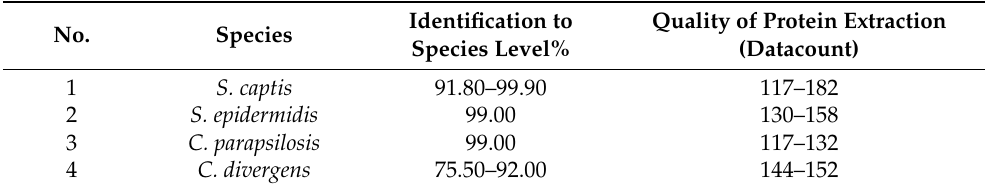
Table 1. Identification of the most common species after the preparation of ceviche using MALDI-TOF technique.